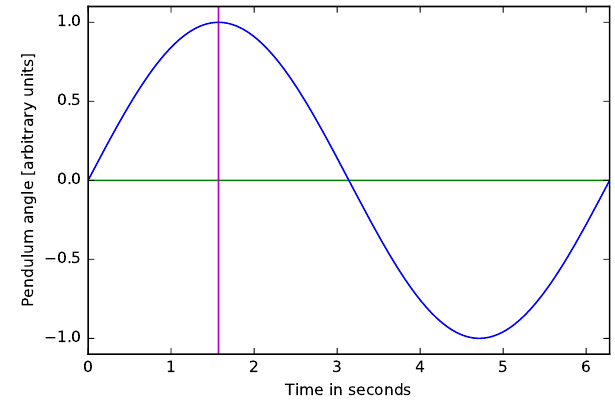
Fig. 85.— Sine curve with horizontal and vertical lines added